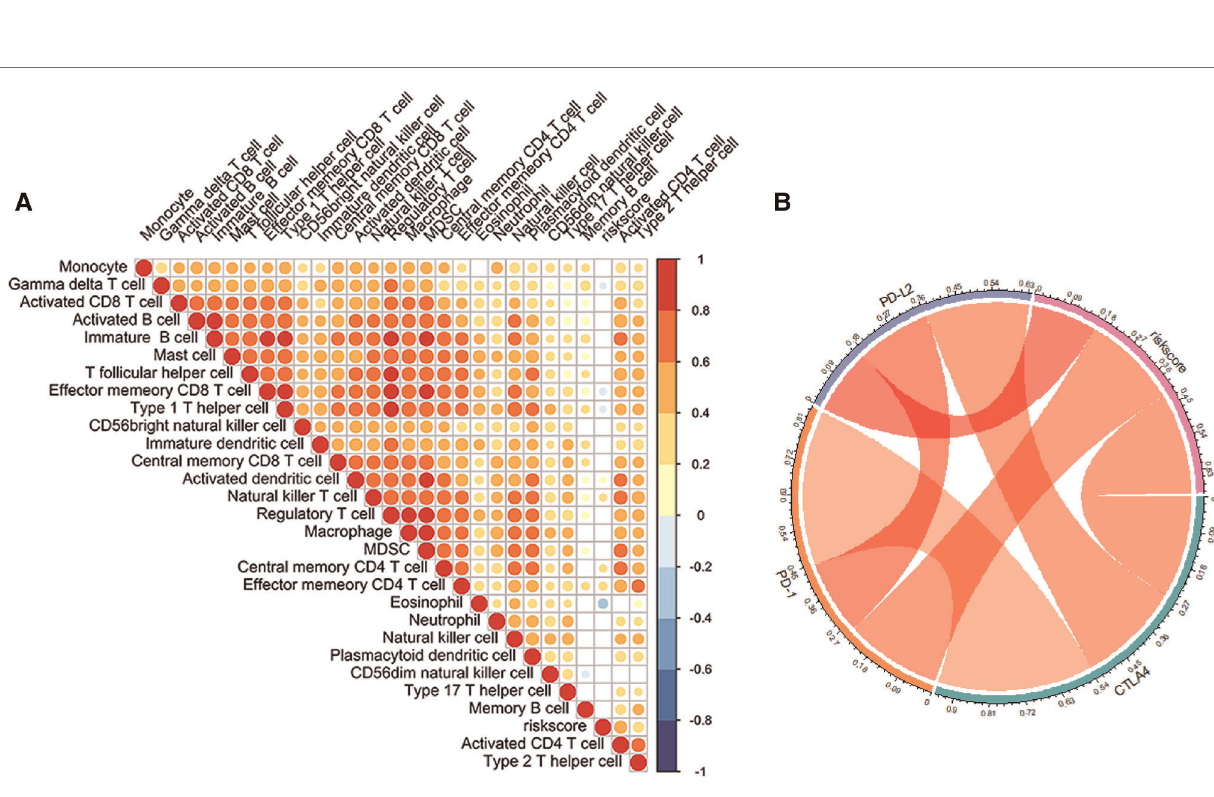
FIGURE 11 | Role of the Risk Score Signature in the TME cell in fi ltration and immune checkpoint molecule. ( A ) Relationship between the Risk Score Signature and the in fi ltration of 28 TME cells. ( B ) Correlation between the Risk Score Signature and immune checkpoint